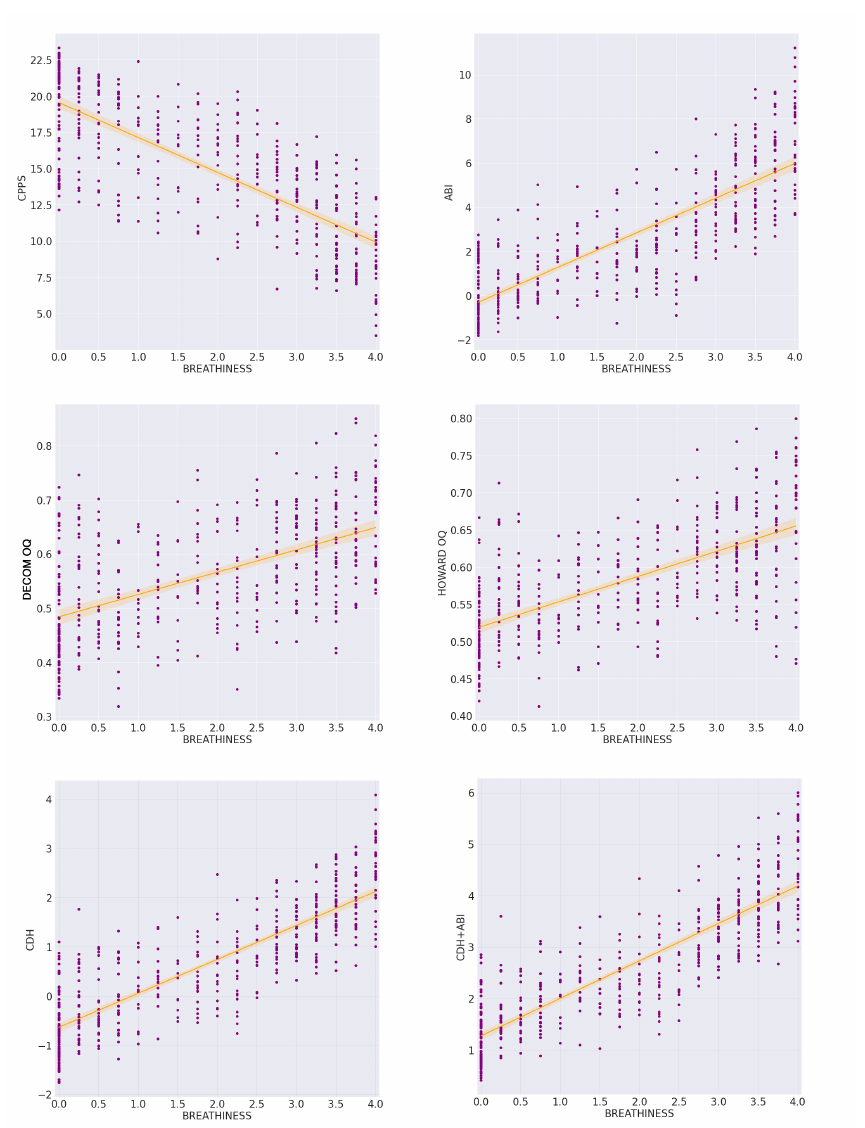
Figure 6. The scatter plots between average breathiness perceptual ratings and the selected acoustic measures: CPP (r = − 0.7655, p < 10 − 5 , ρ = − 0.7647, p < 10 − 5 ), ABI (r = 0.8107, p < 10 − 5 , ρ = 0.8279,